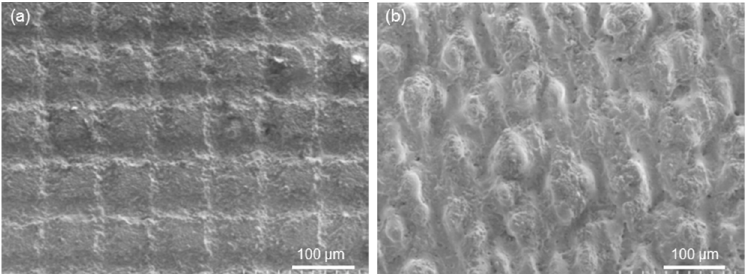
Figure 10. Effect of the parameter Δα on the texture orientation: ( a ) sample 4a ( Δα = 90°) and ( b ) sample 1b ( Δα = 20°).